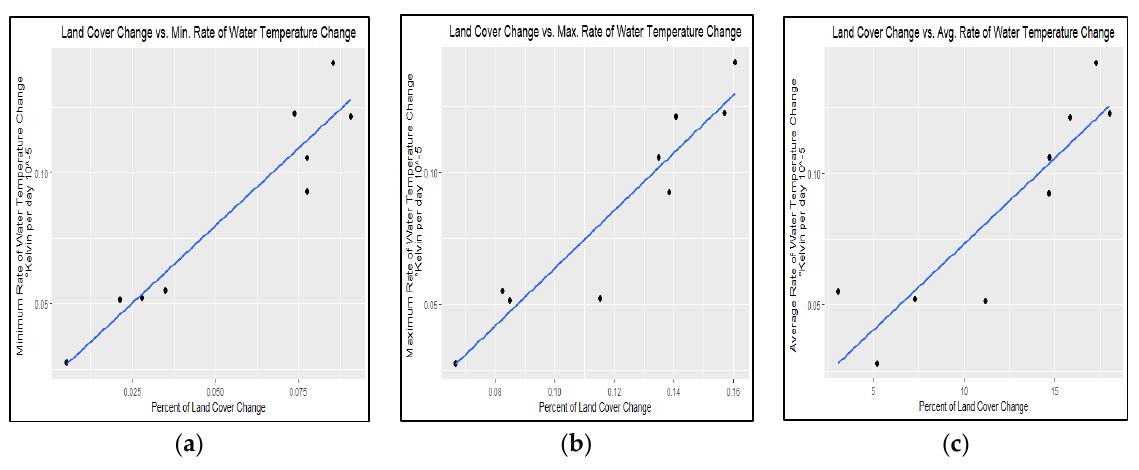
Figure 7. Land Cover Change vs. the minimum ( a ), maximum ( b ) and the average ( c ) rate of water temperature change .